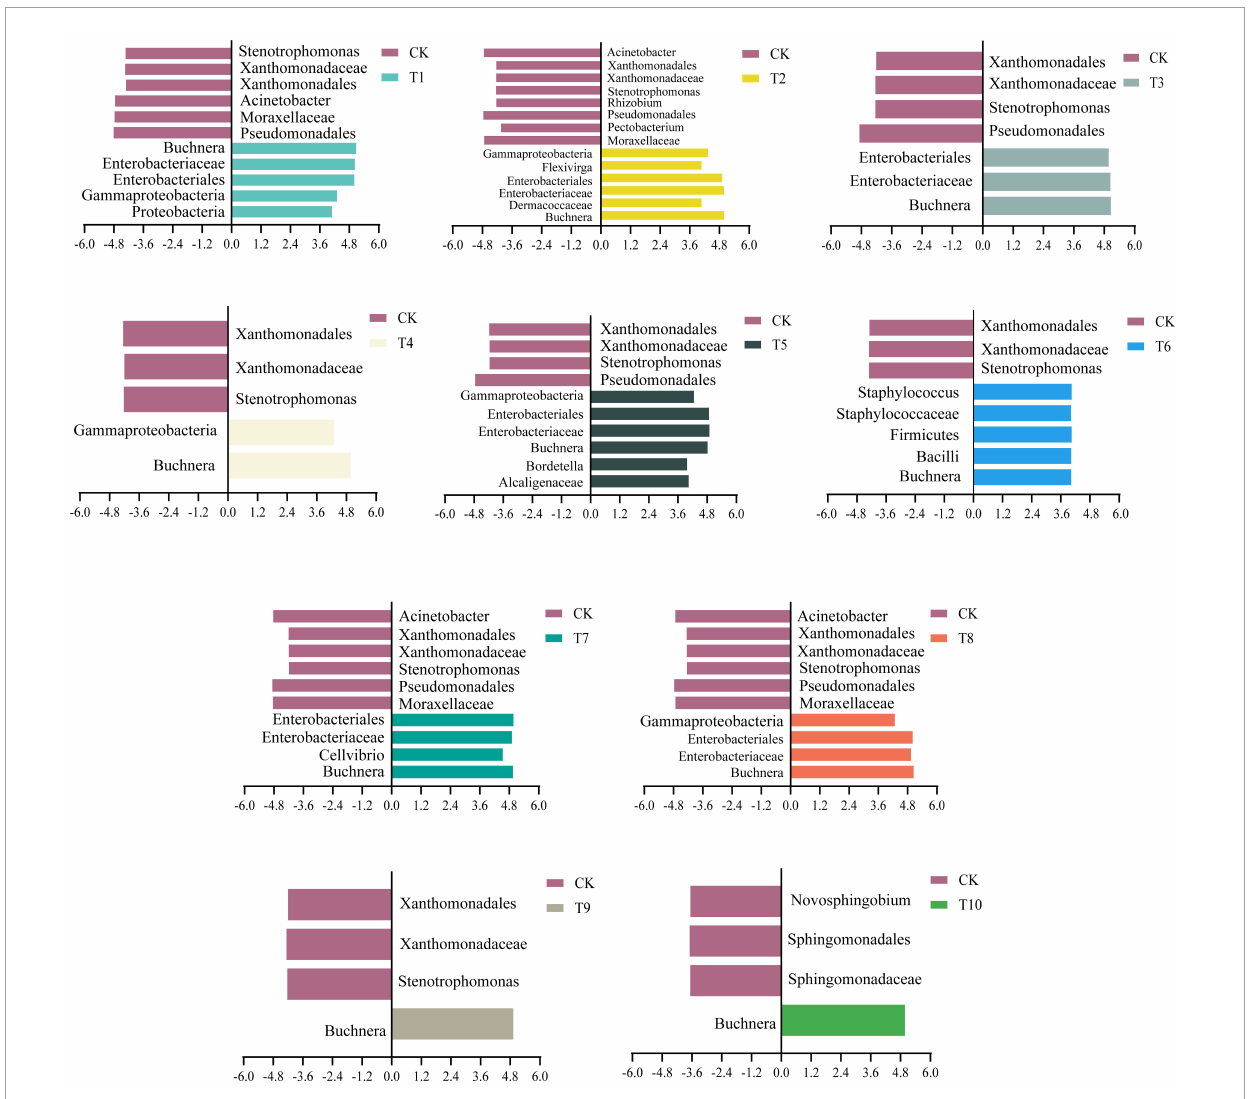
FIGURE3 Comparison of biomarkers of different generations of cotton-specialized aphids on cotton host (CK) and transferred to zucchini host